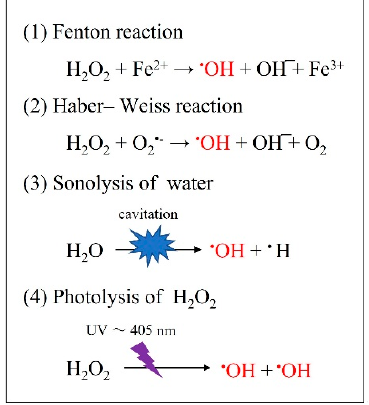
Figure 8. The processes of •OH production.